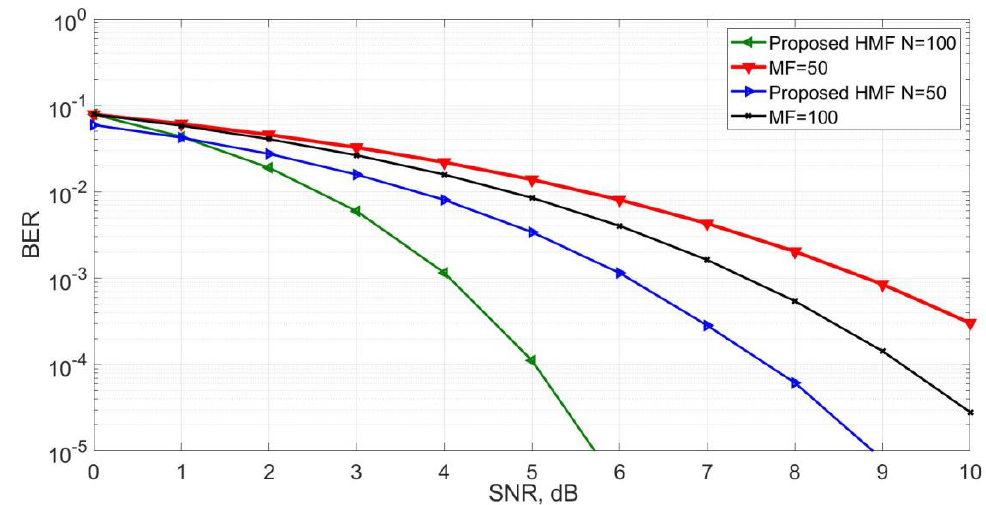
Figure 8. SNR Vs. BER performance for HMF and MF, considering number of samples = 50 and 100 in the Rayleigh Channel.